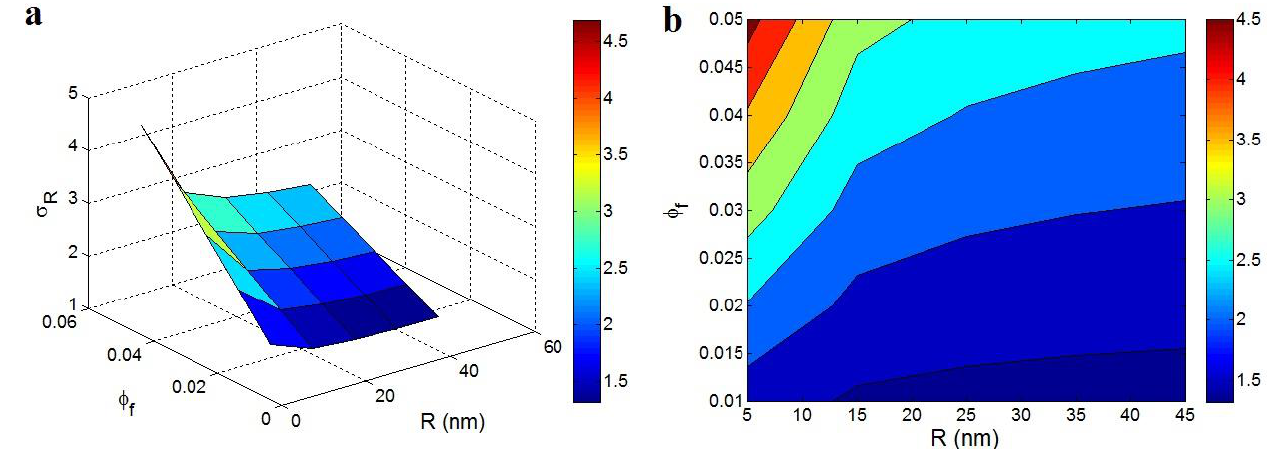
Figure 6. Influences of R and ϕ f on the relative strength as determined using the advanced model: ( a ) 3D and ( b ) contour plots.